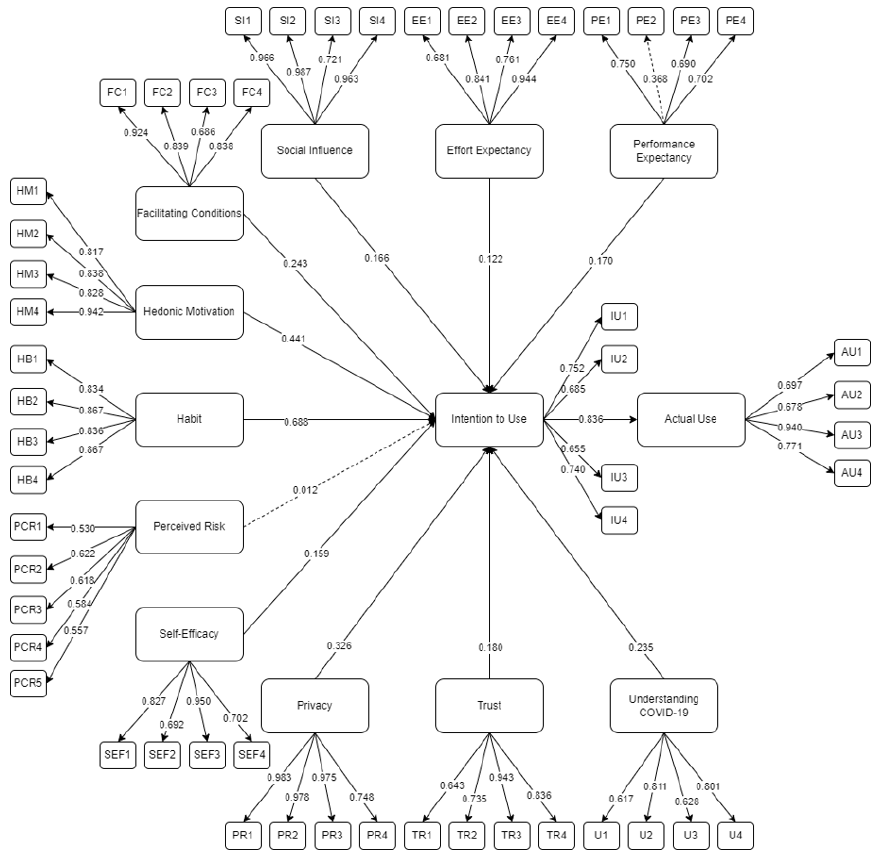
Figure 3. Initial SEM for intention to use the MorChana mobile application.